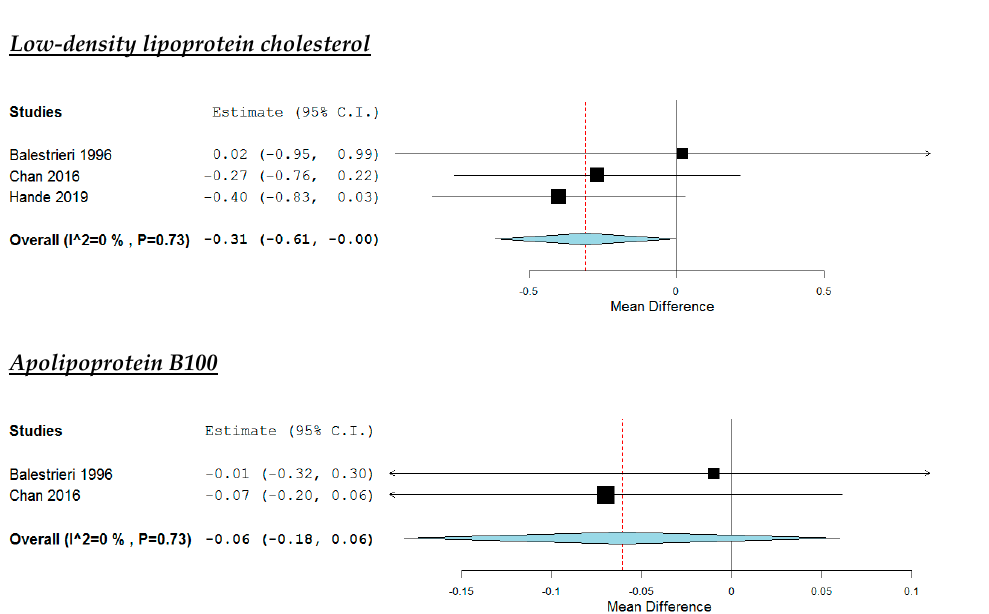
Figure 3. E ff ect of supplementation with omega-3 fatty acids compared with Figure 3. Effect of supplementation with omega-3 fatty acids compared with placebo.